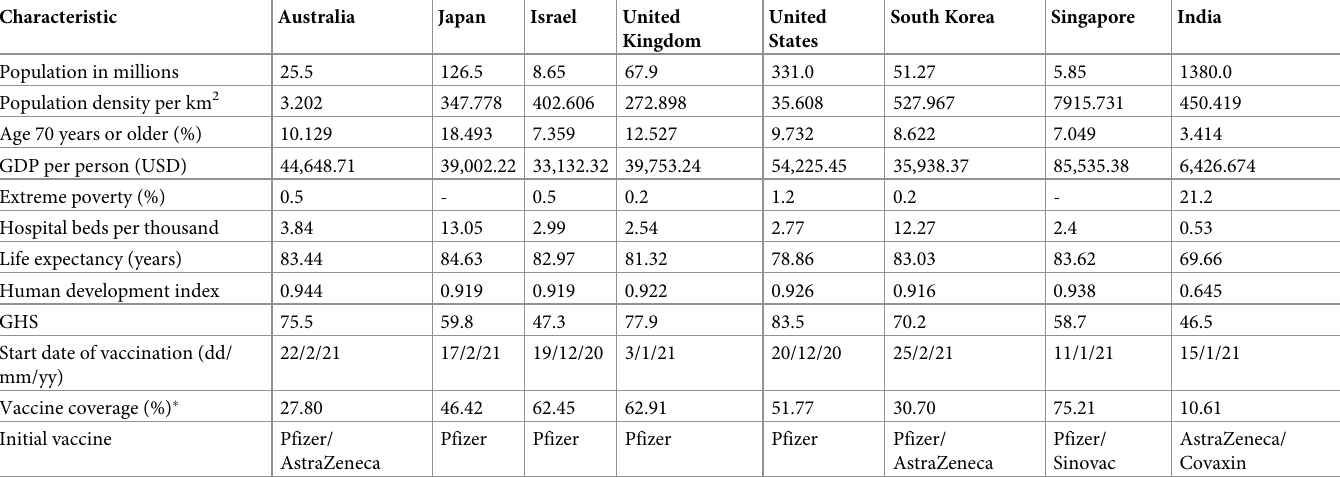
Table 1. Basic characteristics of the selected